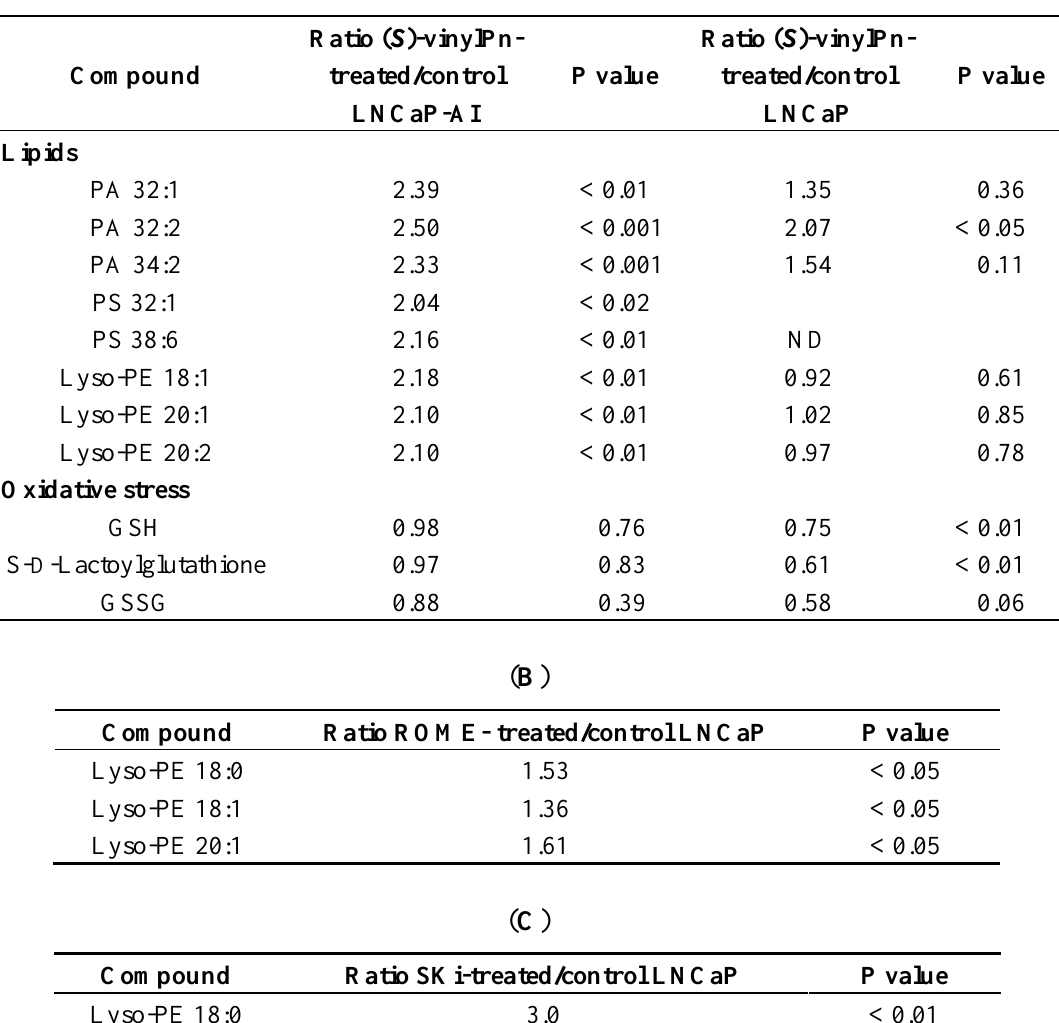
Table 3. Effect of ( A ) ( S )-FTY720 vinylphosphonate (10 μM, 24 h) on metabolite levels